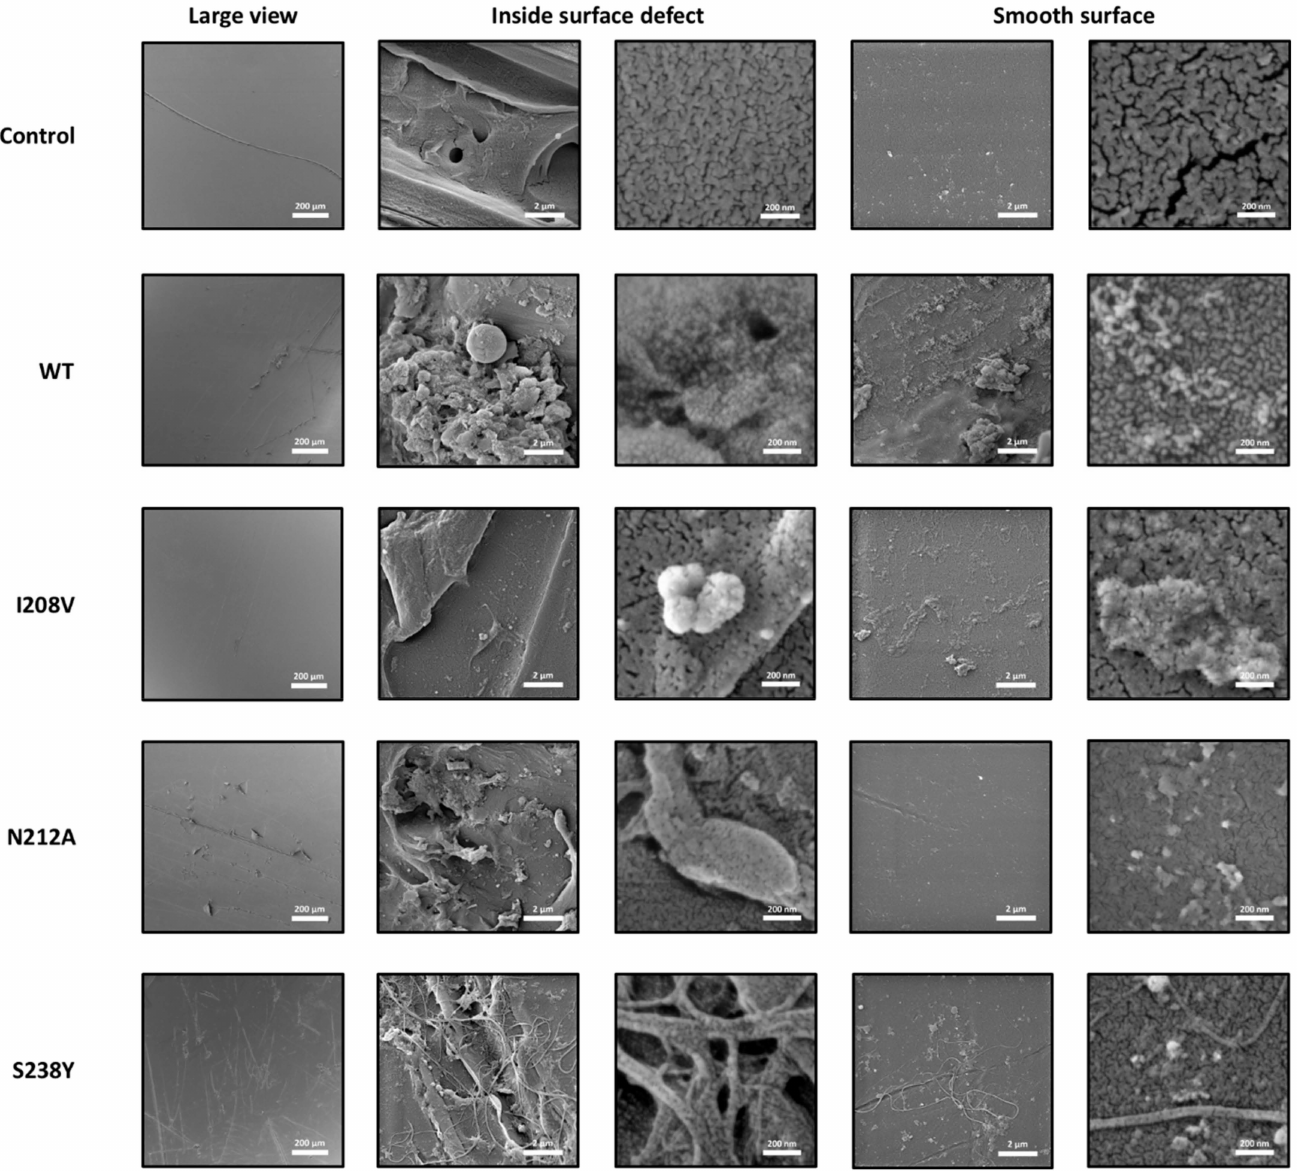
Figure 3. SEM micrographs of PET films degraded by Is PETase WT and mutant variants. All films were incubated in buffer 50 mM glycine-NaOH pH 9.4, with or without enzyme, at 30 ◦ C for 72